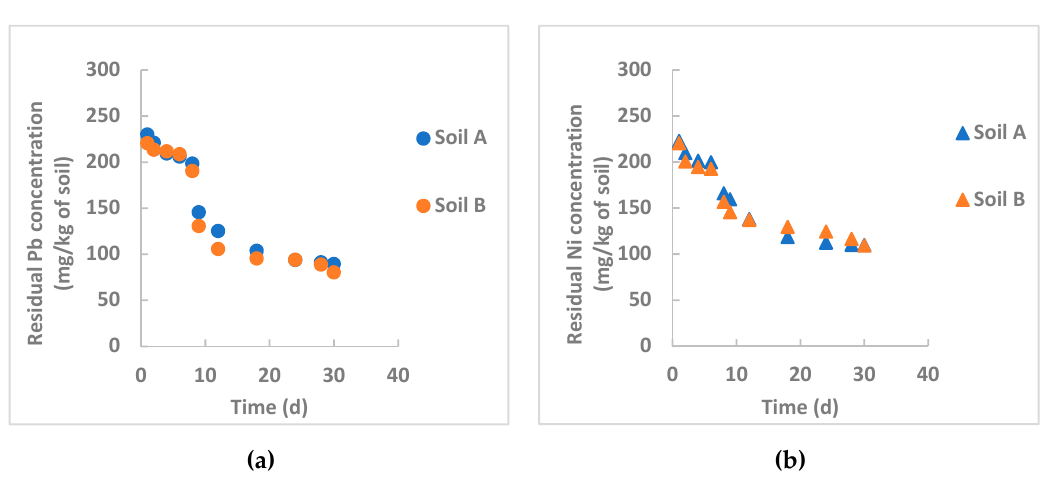
Figure 6. Remediation of nZVI particles synthesized using mint leaves (dosage: 0.1 g / kg of soil): ( a ) lead removal; ( b ) nickel removal.